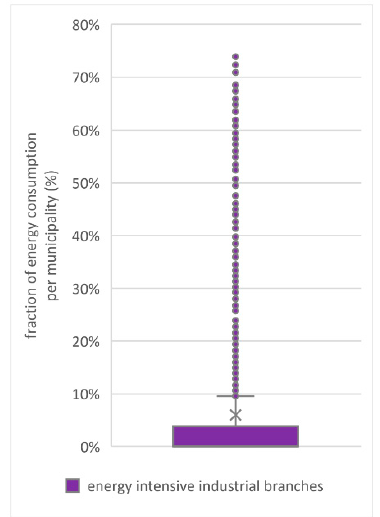
Figure 7. The fraction of energy intensive industrial branches of the energy consumption per municipality.